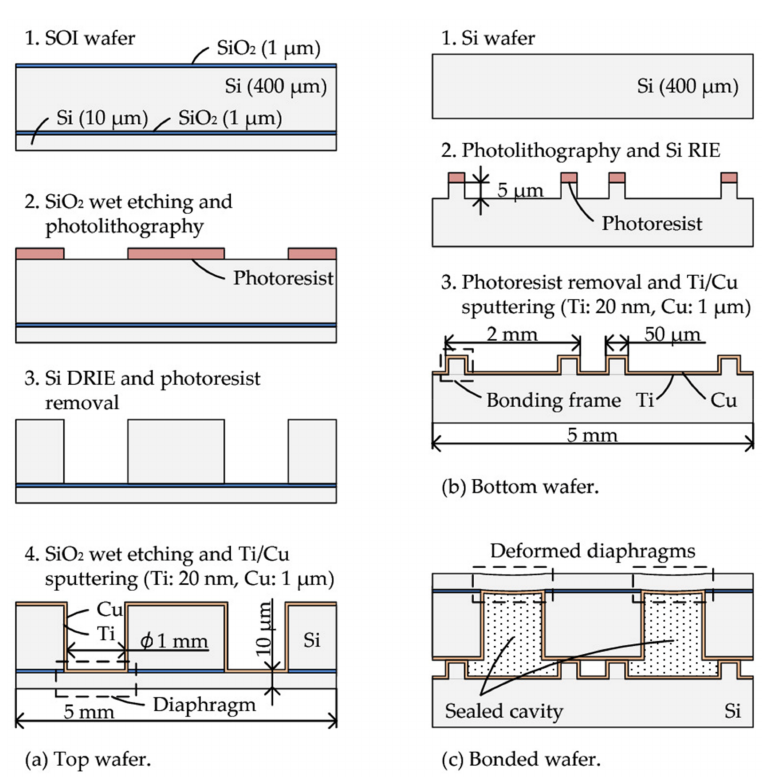
Figure 2. Fabrication processes of ( a ) the top wafer (cavity wafer), ( b ) the bottom wafer (bonding frame wafer) and ( c ) bonded wafer. Both wafer size is 2 cm square. Each wafer has 16 cavities with diaphragms and bonding